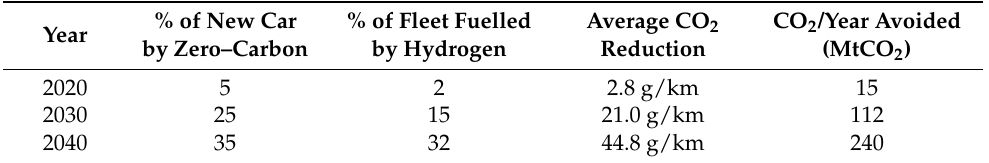
Table 7. Average Greenhouse Gas Emissions [1].